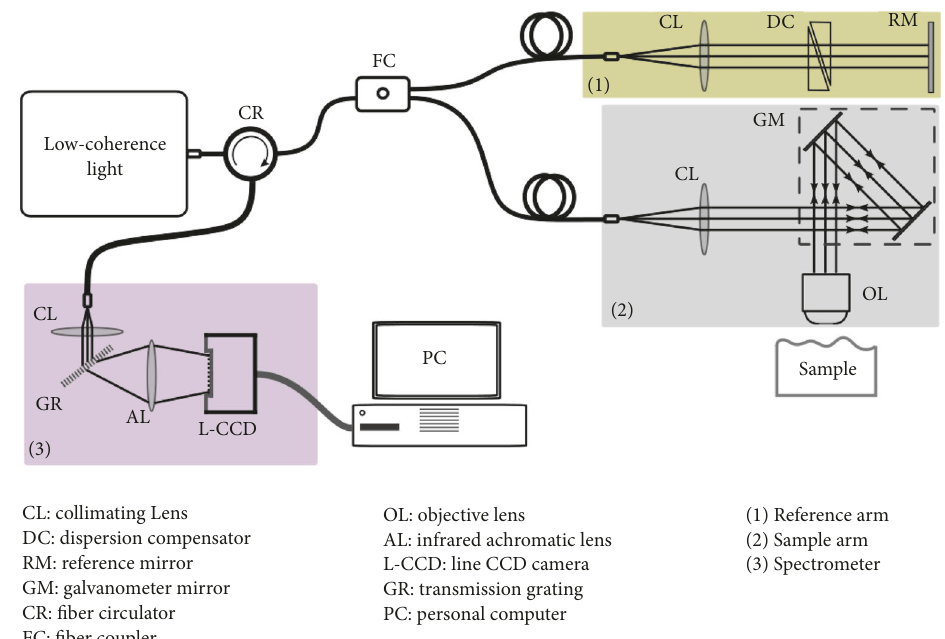
Figure 1: An optical fiber-based spectral-domain OCT scanner. The system uses a low-coherence light source to launch light into both sample (Path 2) and reference (Path 1) arms. In the sample arm, a set of galvanometric mirrors raster-scan the sample under test. Light that is collected back from the reference and sample arms recombines to form interference patterns which are detected by the spectrometer (Path